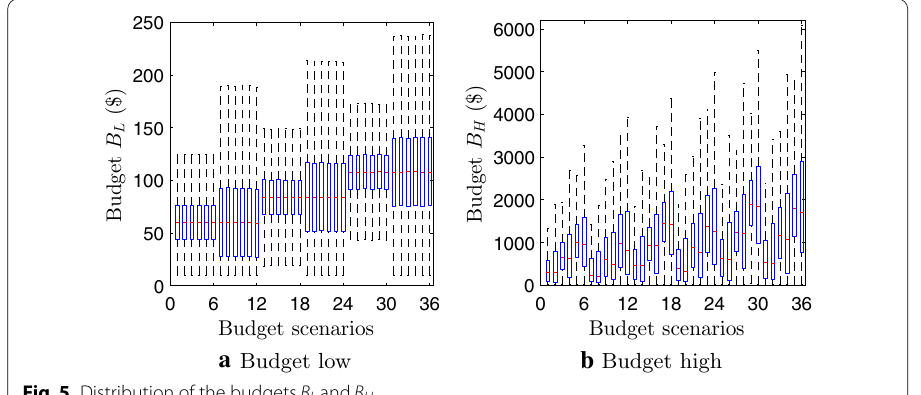
Fig. 5 Distribution of the budgets B L and B